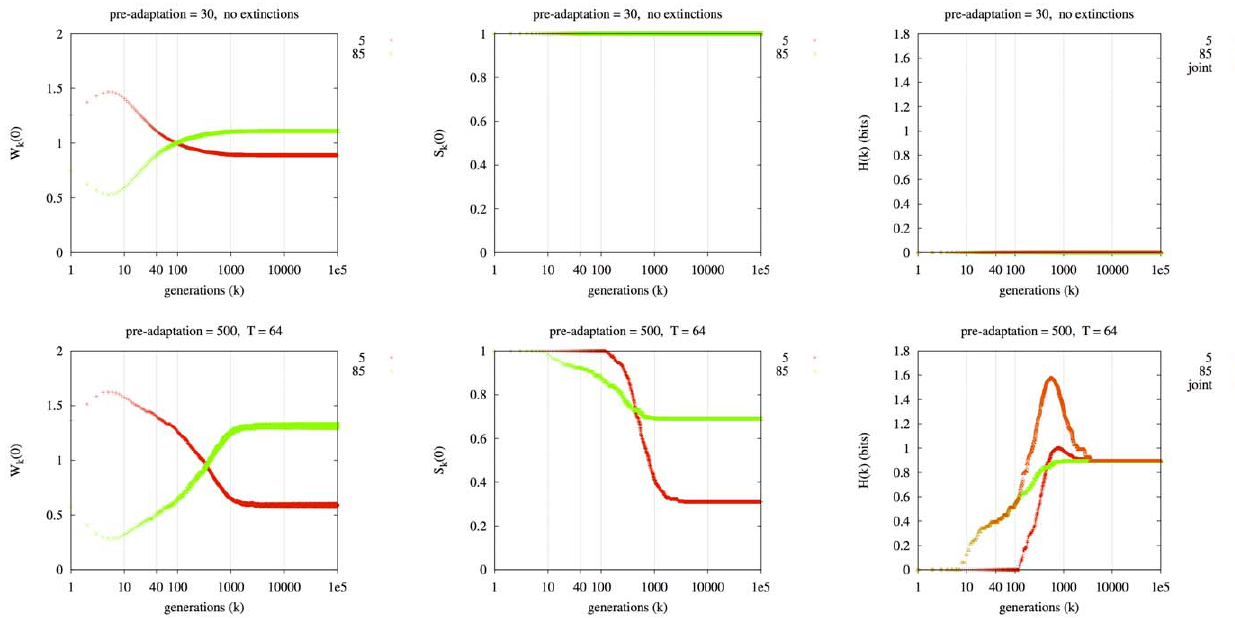
Figure 6. An initially better-adapted lineage (red, a =5) competes against a more lineage that produces better variation and therefore adapts quicker (green, a =85). First row: short pre-adaption (30 generations), but no per-deme extinctions. Second row: long pre- adaptation (500 generations), per-deme extinctions at mean period T=64. D=16, ND=1024.